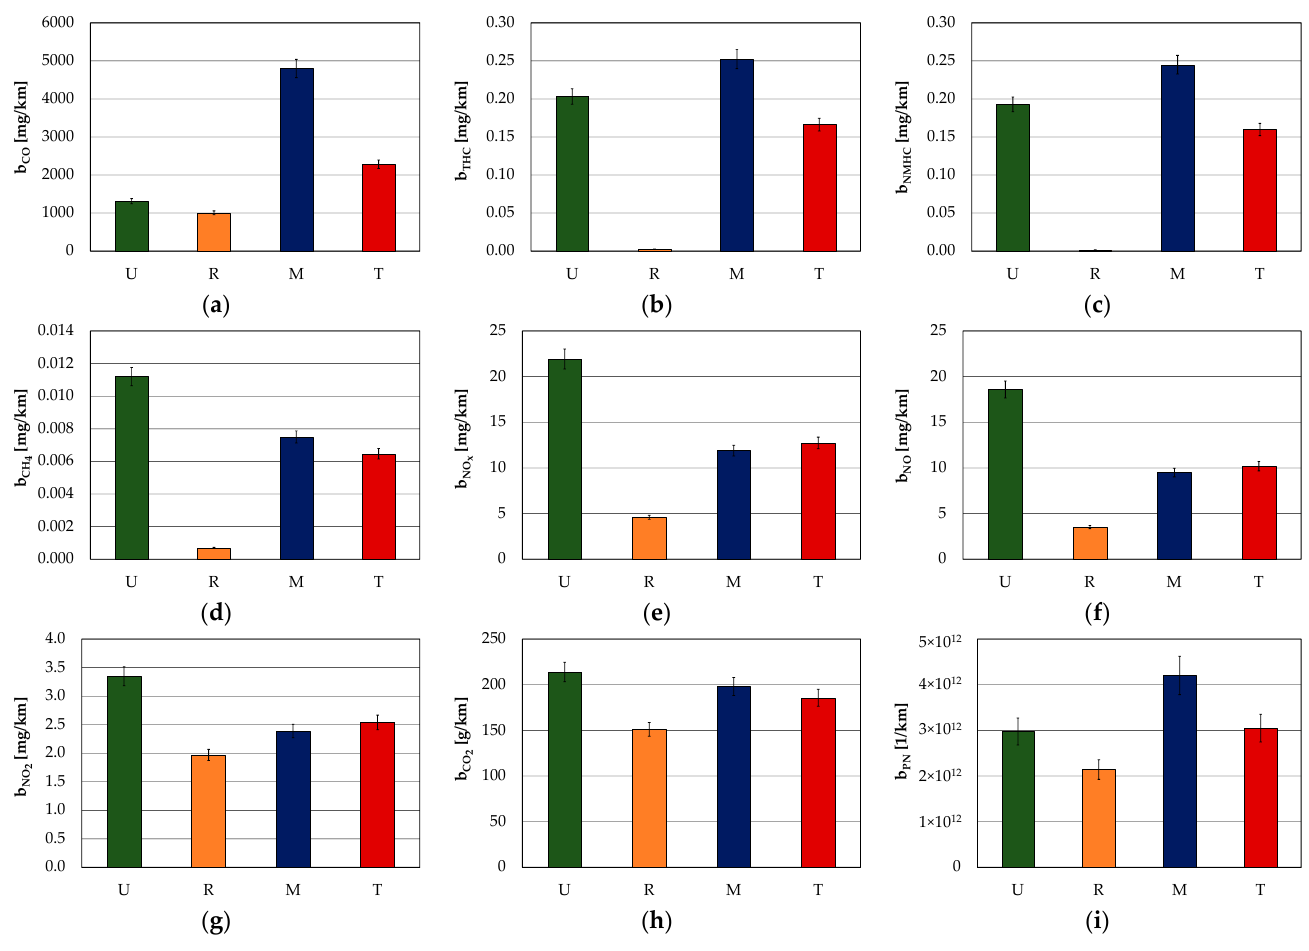
Figure 3. Mean road exhaust emissions in the different phases of the RDE test (U–Urban, R–Rural, M–Motorway, T–Total) for: ( a ) carbon monoxide; ( b ) hydrocarbons; ( c ) non-methane hydrocar- bons; ( d ) methane; ( e ) nitrogen oxides; ( f ) nitrogen oxide; ( g ) nitrogen dioxide; ( h ) carbon dioxide; ( i ) number of emitted particles.